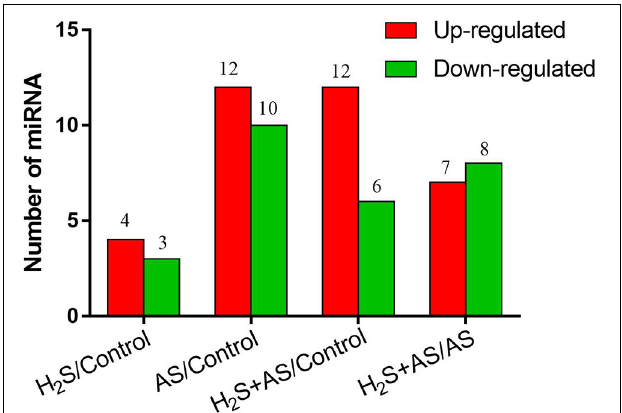
FIGURE 4 | The number of upregulated and downregulated miRNAs. Number of differentially expressed miRNAs in M. hupehensis under H 2 S, H 2 S + AS, and AS stresses as compared with the control